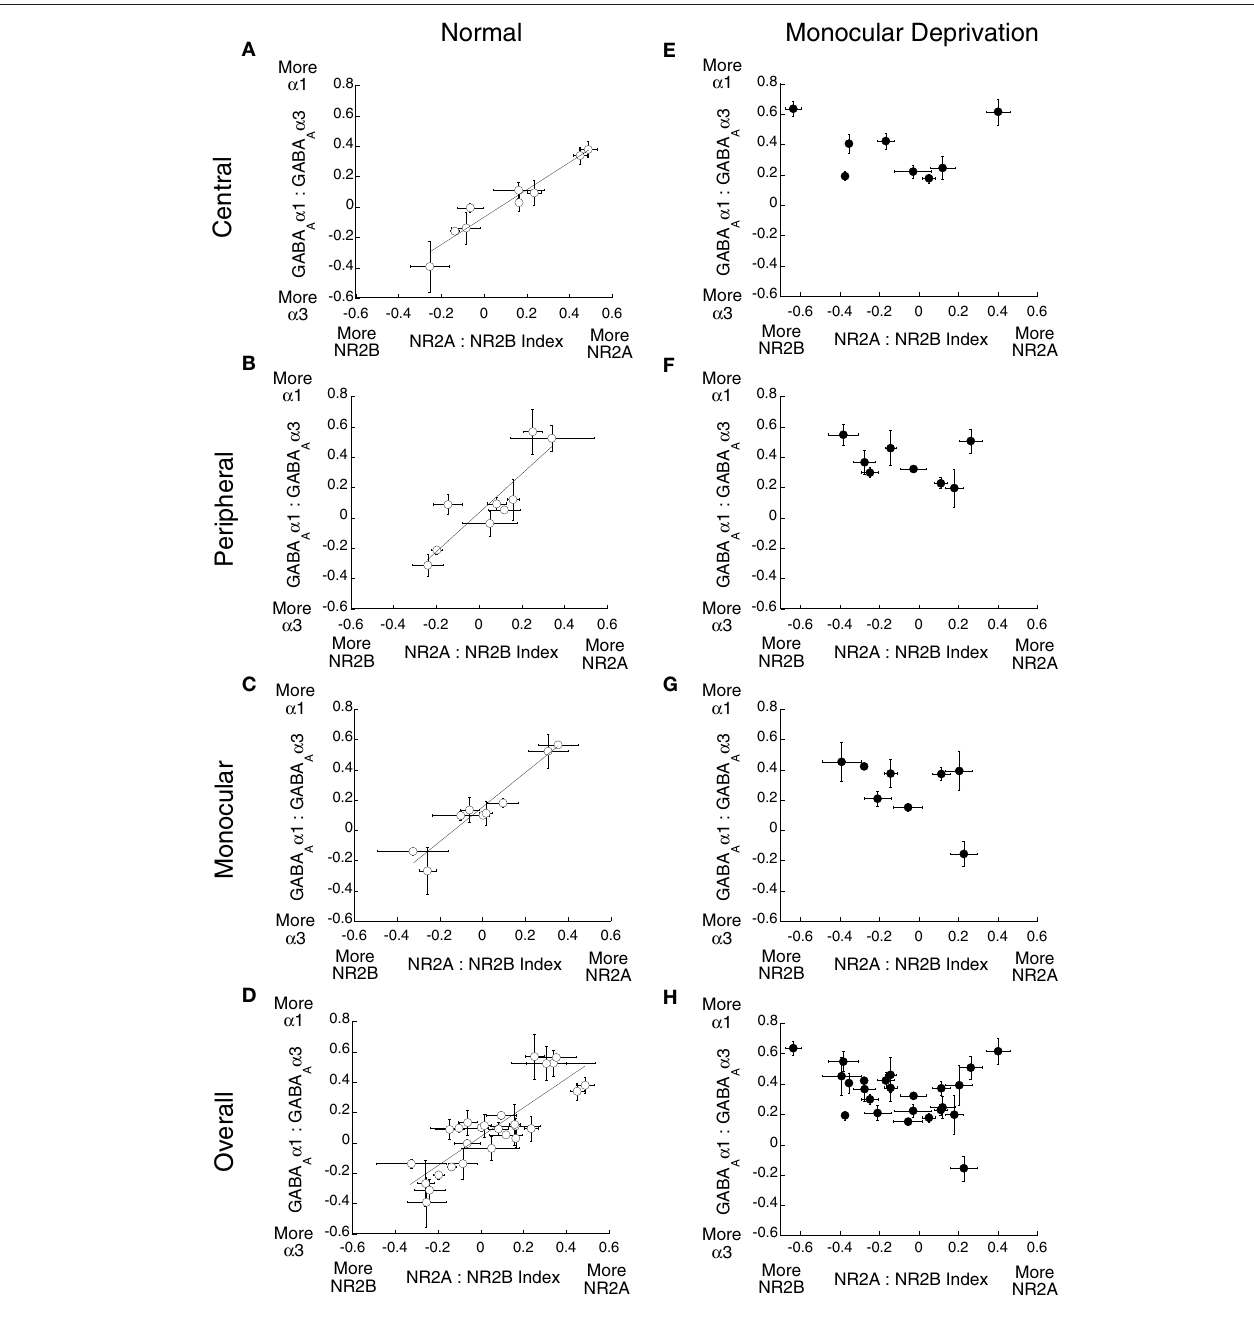
FiGure 7 | Monocular deprivation disrupts the balance between Nr2A:Nr2B and GABA α 1:GABA α 3. The relationship between these indices A A was plotted for (A–D) normal and (e–H) monocularly deprived animals. Significant